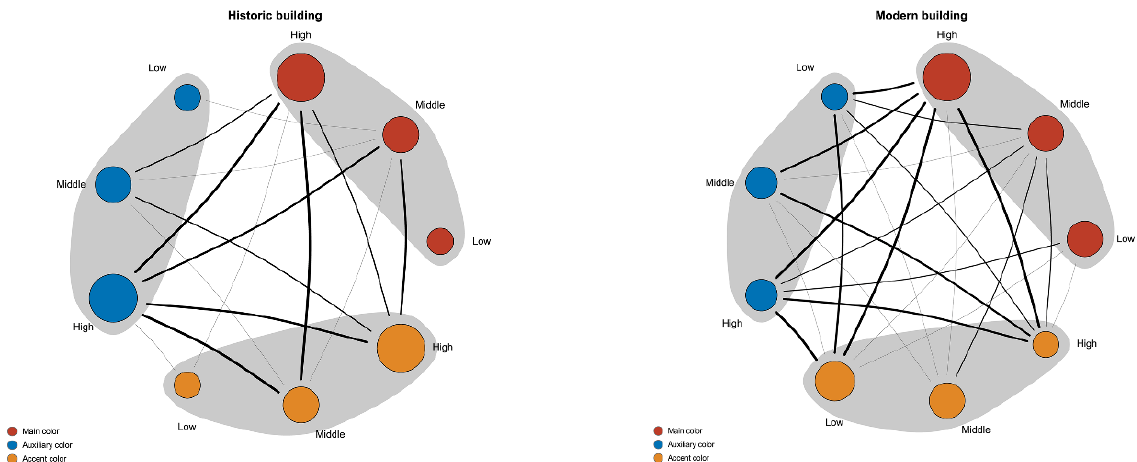
Figure 10. Composition network of color brightness levels of historic and modern buildings.